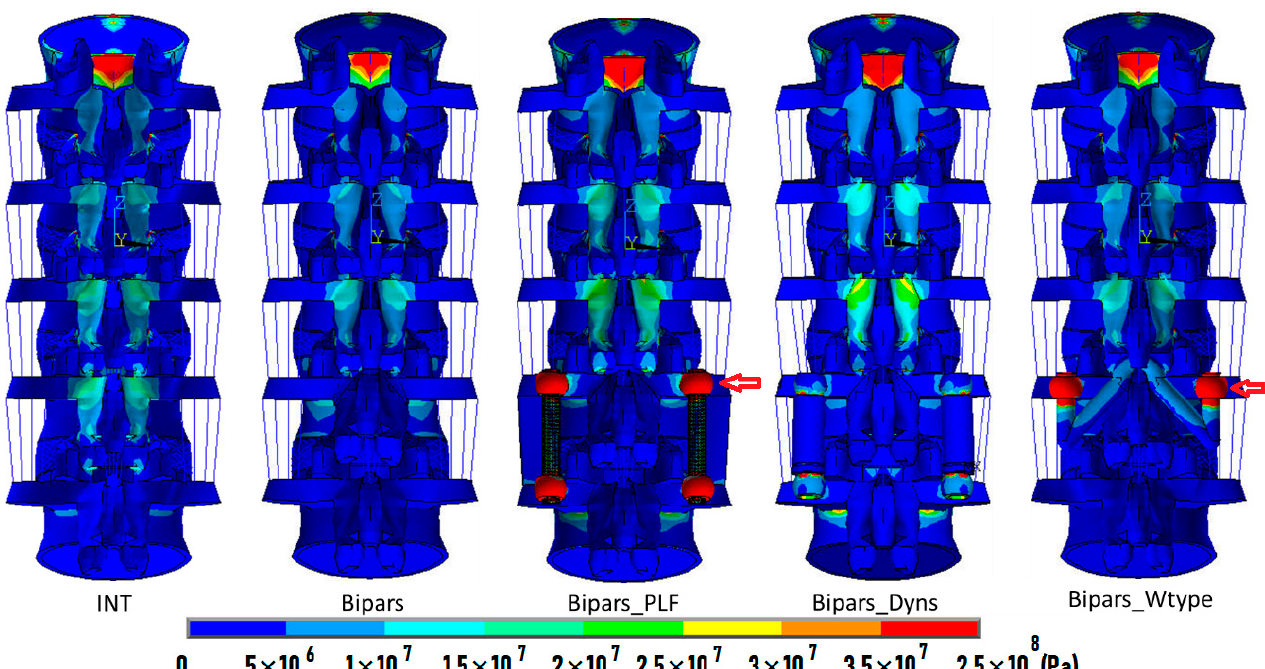
Figure 6. Stress distribution in all FE models in extension. High stress at screw heads was observed in the Bipars_PLF and Bipars_Wtyp models as indicated by the red arrows. In the Bipars_PLF and Bipars_Dyn models, the disc stress of the cranial segments increased by 29% and 19%, respectively, compared with the INT model. In the Bipars_Wtyp model, disc stress was 8% lower than in the INT model. Apparently, the high stress acted on the posterior region of the adjacent disc in the Bipars_Dyn and Bipars_Wtyp model, as shown in Figure 7. Minor changes were observed in the INT and Bipars_Wtyp model. It could be explained why early adjacent disc degeneration was observed in the B_PLF and Bipars_Dyn treatment. The adjacent segment FCFs were increased in the Bipars_PLF and Bipars_Dyn models by 32% and 19%, respectively; this value decreased in the Bipars_Wtyp